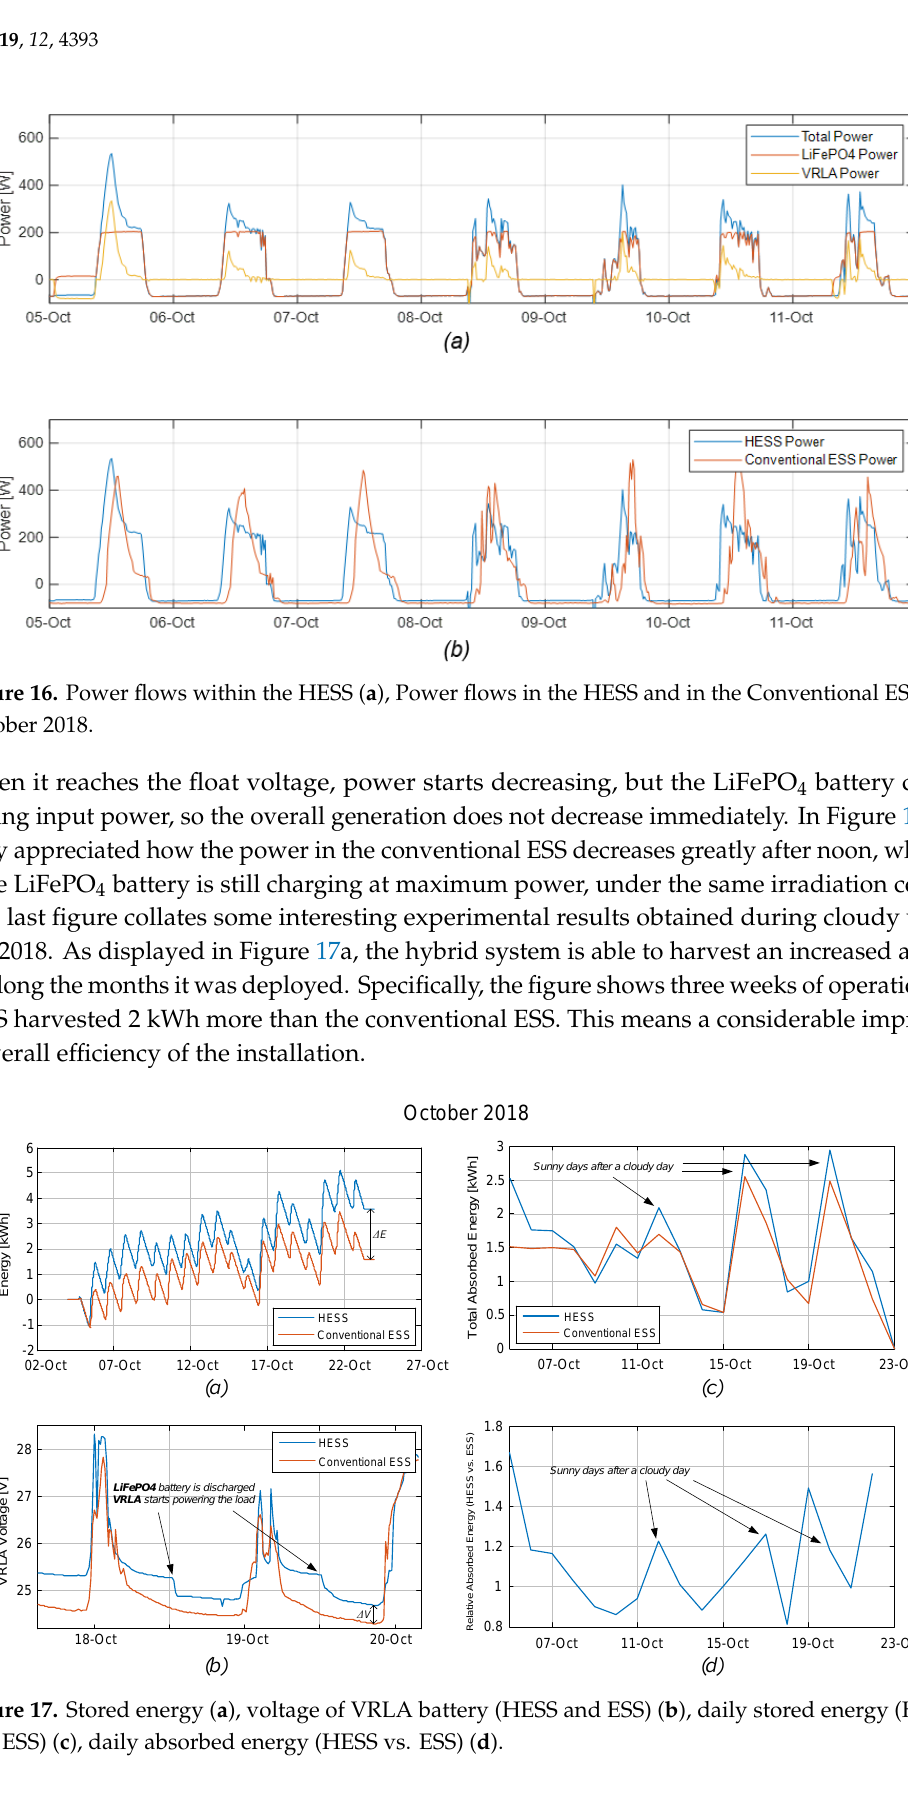
Figure 17. Stored energy ( a ), voltage of VRLA battery (HESS and ESS) ( b ), daily stored energy (HESS and ESS) ( c ), daily absorbed energy (HESS vs. ESS) ( d ).